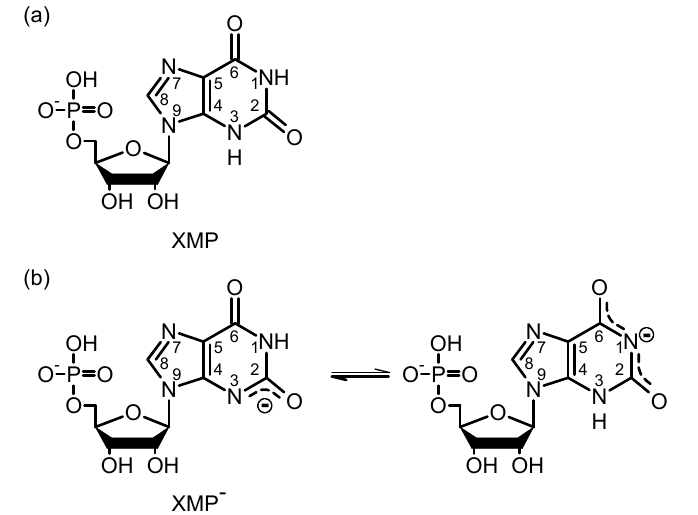
Figure 1. Structures of xanthosine monophosphate at ( a ) acidic and ( b ) neutral pH. The numbers 1–9 indicate the atom labels in the purine